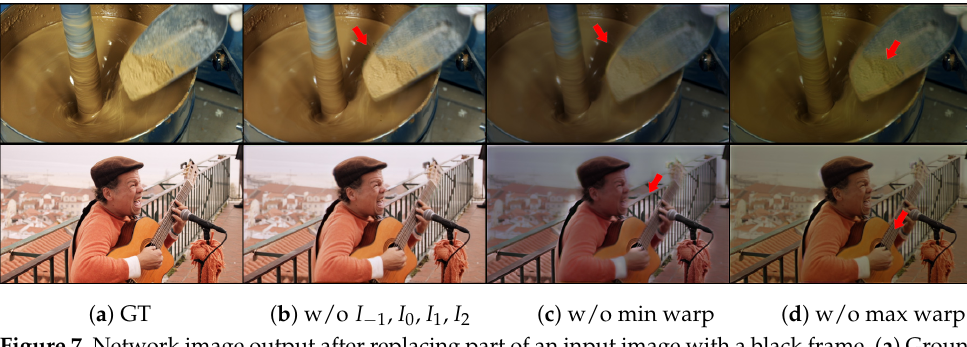
Figure 7. Network image output after replacing part of an input image with a black frame. ( a ) Ground Truth. ( b ) Video with only input image replaced with black frame. ( c ) Video with only min-warped image replaced with black frame. ( d ) Only max-warped image was replaced with black frame